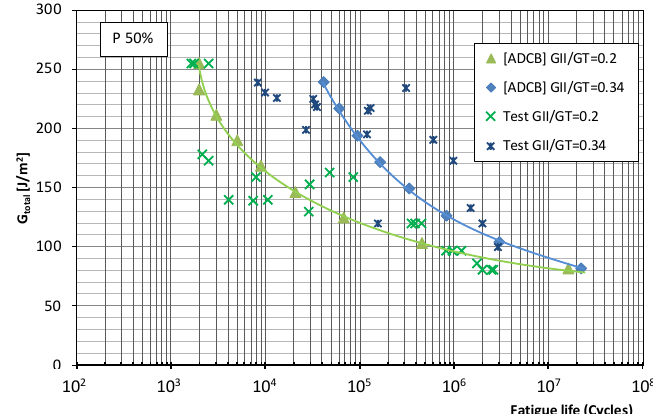
Figure 6. Material fatigue curves, ADCB test, for a 50% probability of fracture and two mode mixity ratios: 0.2 and 0.34.